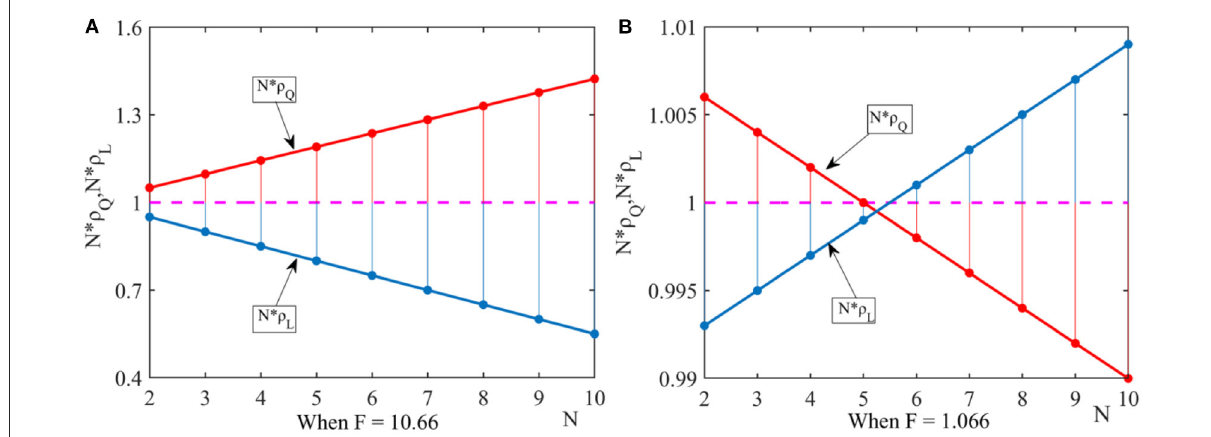
FIGURE1 Effect of the number of pharmaceutical enterprises on fixed point probability. This figure shows that under the dominance of external factors, the effect of the number of pharmaceutical enterprises on fixed point probability when considering different government penalty. (A) When F = 10.66, (B) When F =